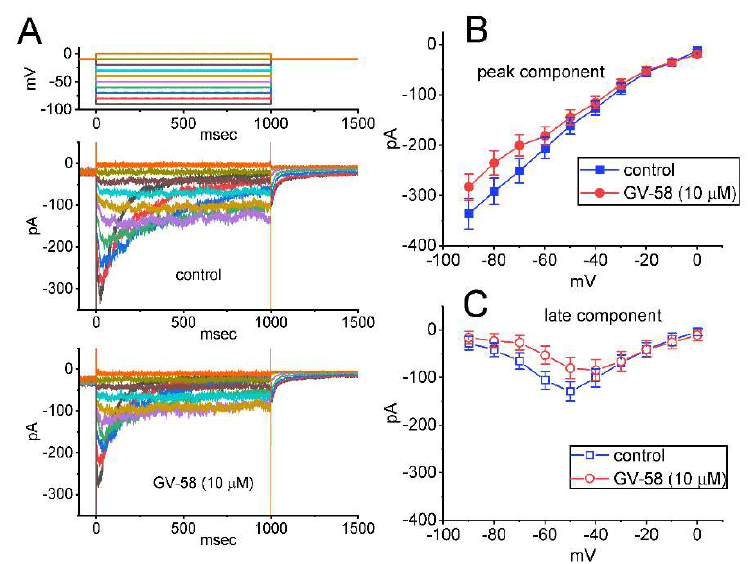
Figure 10. Effects of GV − 58 on erg − mediated K + current ( I K(erg) ) in GH 3 cells. In these experiments, we kept cells bathed in high-K + , Ca 2+ − free solution containing 1 µ M TTX, and the patch pipette was filled up with K + − containing solution. The composition of these solutions is elaborated in Table 1. ( A ) Representative current traces activated by a series of voltage pulses (indicated in the uppermost part). Current traces shown in the upper part were obtained during the control period, whereas those in the lower part were acquired in the presence of 10 µ M GV − 58. In ( B , C ), the mean current − voltage ( I–V ) relationships of peak (upper, filled symbols) and sustained (lower, open symbols) components of I K(erg) achieved in the absence (square symbols) or presence (circle symbols) of 10 µ M GV − 58 are illustrated, respectively. The peak and sustained components of I K(erg) were measured at the beginning and end − pulse of each voltage pulse, respectively. Each bar in ( B , C ) represents the mean ± SEM (n = 8). Of notice, the presence of 10 µ M GV − 58 mildly suppresses the magnitude of I K(erg) in these cells.